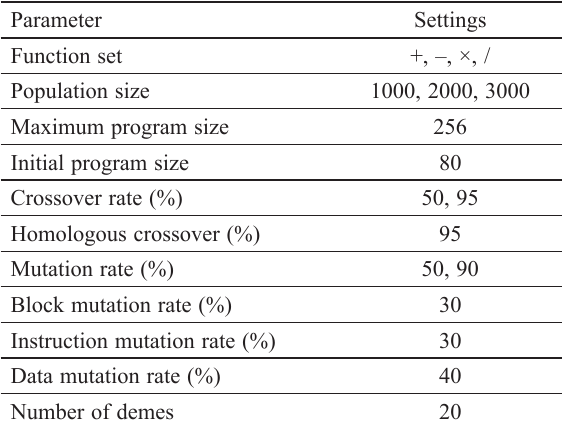
Table 5. Parameter settings for the LGP algorithm Parameter